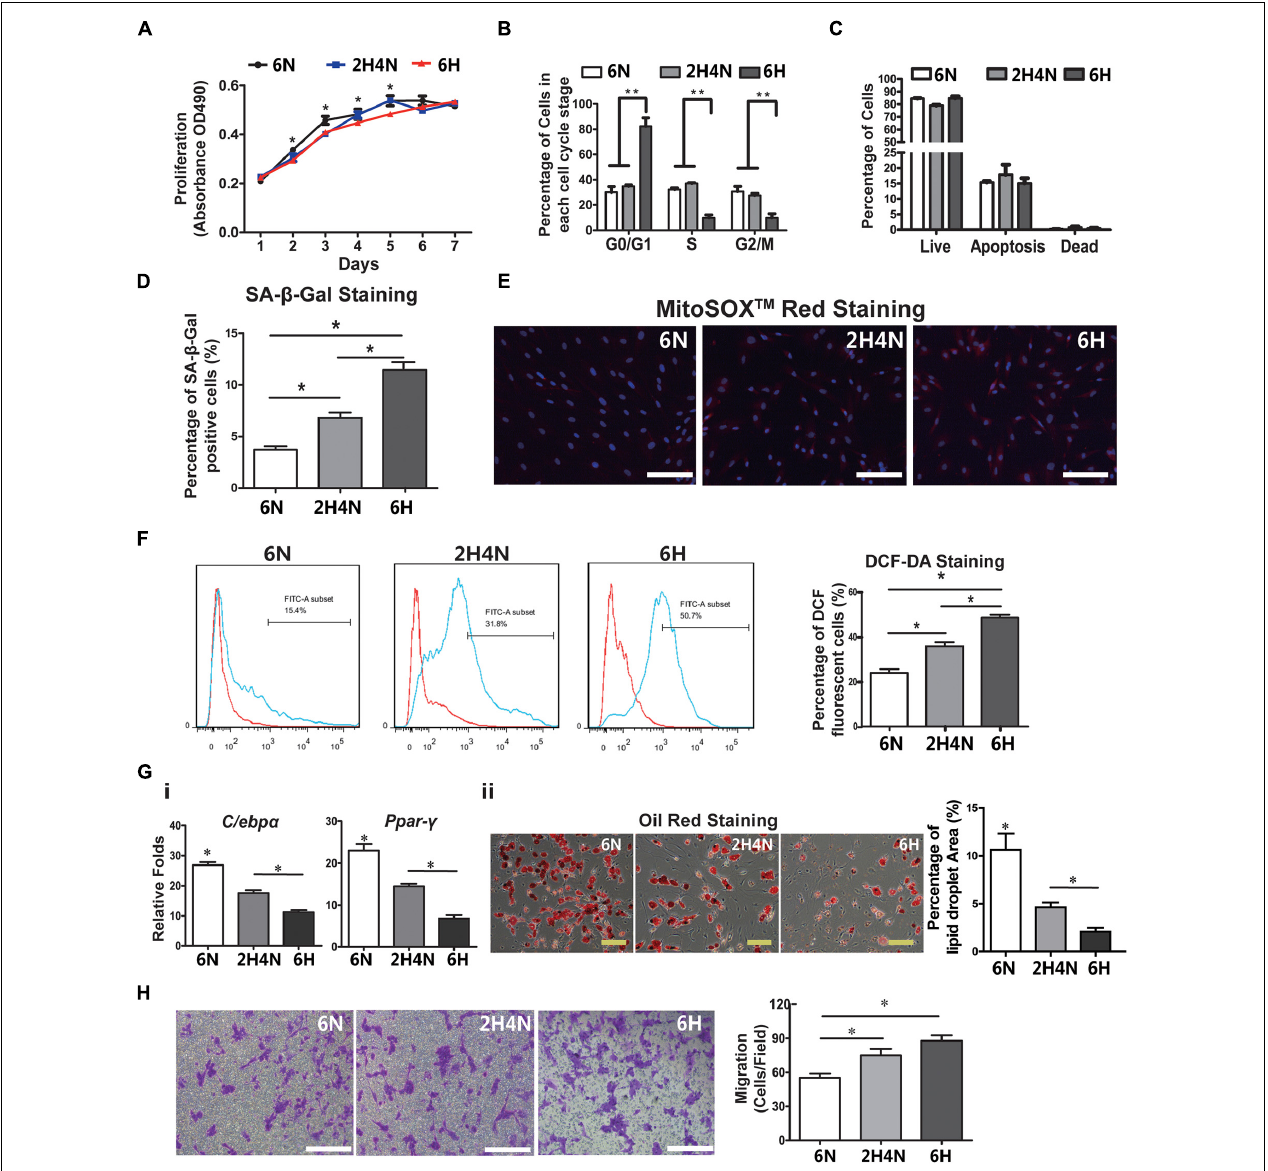
FIGURE 8 | BMSC functions cannot be reversed by dietary intervention. (A–C) Cell proliferation (A) , cell cycle (B) and apoptosis analysis (C) of BMSCs in 6N, 6H and 2H4N groups. (D) Percentage of SA- β -Gal-positive senescent cells of BMSCs in 6N, 6H and 2H4N groups. (E,F) The MitoSOXTM Red staining (E) and the measurement of reactive oxygen species (ROS) levels as judged by DCF fluorescence analyzed by flow cytometry after DCF-DA staining (F) of BMSCs in 6N, 6H and 2H4N groups, n = 5. (G) Expression of adipogenic markers (i) and oil-red staining (ii) of adipogenic-induced BMSCs in 6N, 6H and 2H4N groups. (H) and crystal violet staining of BMSCs in the 6N, 6H and 2H4N groups, n = 5. Significance was calculated by one-way ANOVA followed by Tukey’s post hoc test, * p < 0.05, ** p < 0.01. Scale bars, 50 µ m.